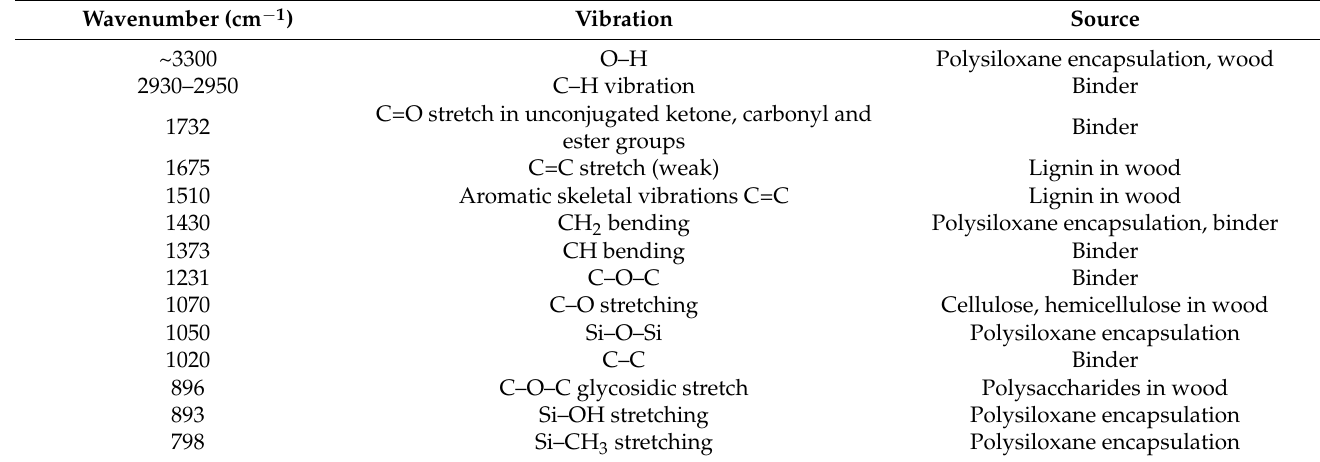
Table 6. FTIR peaks corresponding to their respective